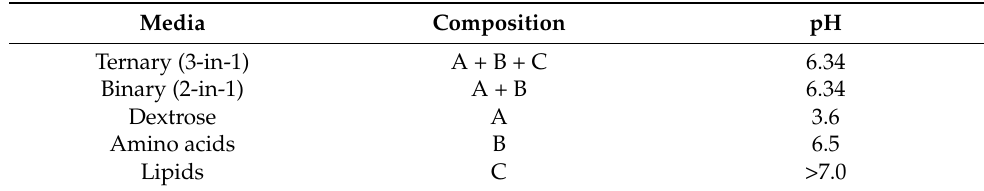
Table 1. Composition and pH values of PN media compounded from an Olimel TM N7E bag Dextrose 35% solution + calcium (A), amino acids 11.1% solution + electrolytes except calcium (B) and lipid emulsion 20%